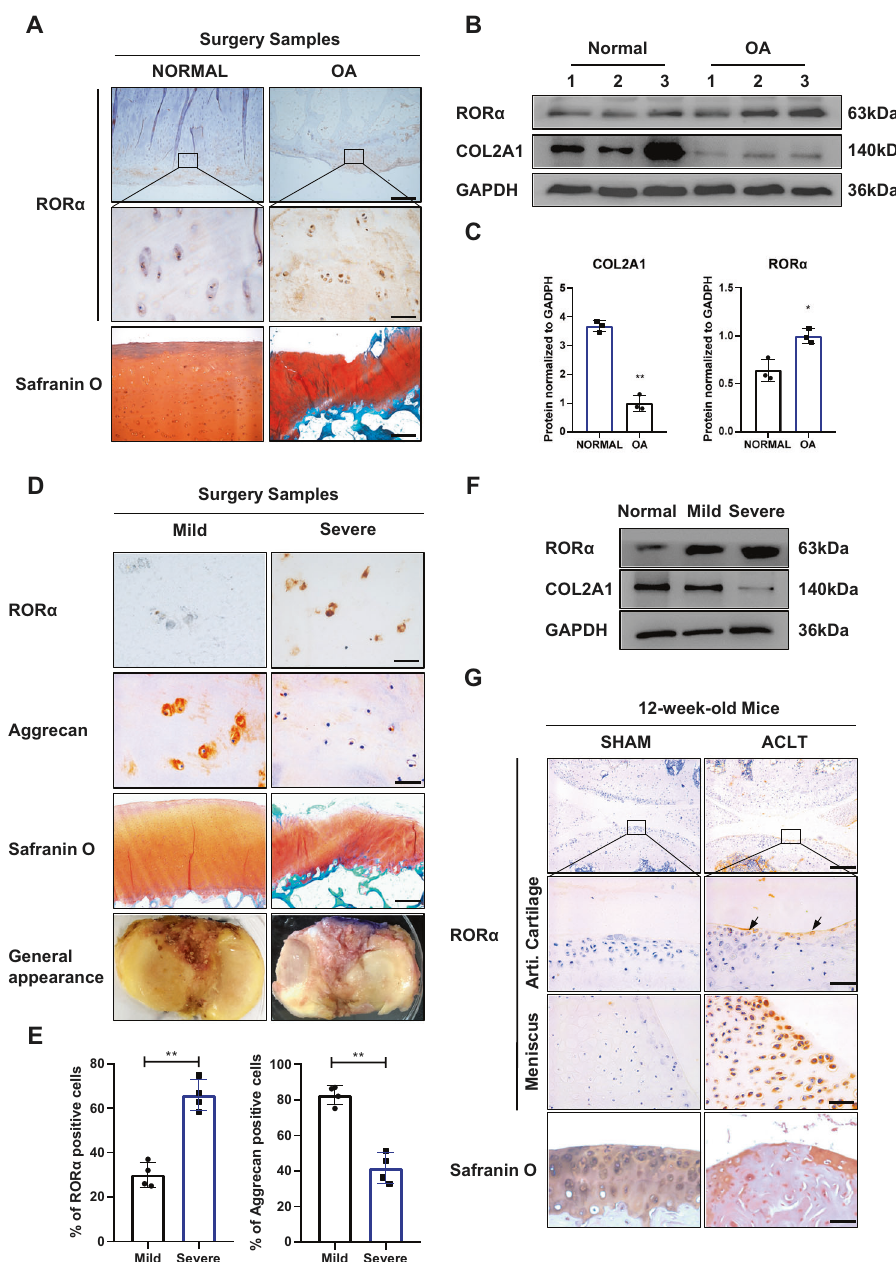
Fig. 1 The expression level of ROR α is positively correlated with the severity of OA and cartilage damage in human OA samples and surgery-induced OA mice model. A IHC and safranin O staining for detection of ROR α in OA samples and controls. Boxed areas indicate the typical area of ROR α expression. Scale bars, 500 and 50 μ m for ×40 and ×400 images, respectively. B Representative western blot images for detection of ROR α and COL2A1 in the cartilage tissue from control and OA patients ( n = 3). C The quanti fi cation of western blot for detection of ROR α and COL2A1 from OA patients and normal control. D Representative images of IHC staining for ROR α and aggrecan, Safranin O staining, and the general appearance of different severity of OA samples. Scale bars, 50 μ m for IHC staining and 500 μ m for Safranin O staining images. E The percentage of ROR α -positive cells and aggrecan-positive cells in mild or severe degenerated cartilage samples from OA patients ( n = 4). F Western blot for detection of ROR α and COL2A1 from the cartilage tissue of different severity of OA. G IHC and safranin O staining for ROR α in mouse knee joints articular cartilage and meniscus 8 weeks after OA mouse model creation via ACLT surgery ( n = 3). Scale bars, 200 and 50 μ m for the upper and the middle images, respectively. The statistical data in C and E were analyzed with Student ’ s t test. * P < 0.05; ** P < 0.01. All data shown above are presented as the mean ± including Janus Kinase (JAK) and signal transducer and activator of transcription (STAT). The result of RNA-seq con fi rmed that ROR α regulated different biological processes in chondrocytes, including cartilage ECM homeostasis, cholesterol metabolism, downregulated (Fig. 4E). IL-6 response pathway included several and in fl ammation response. kinases and factors that participated in signal transduction,